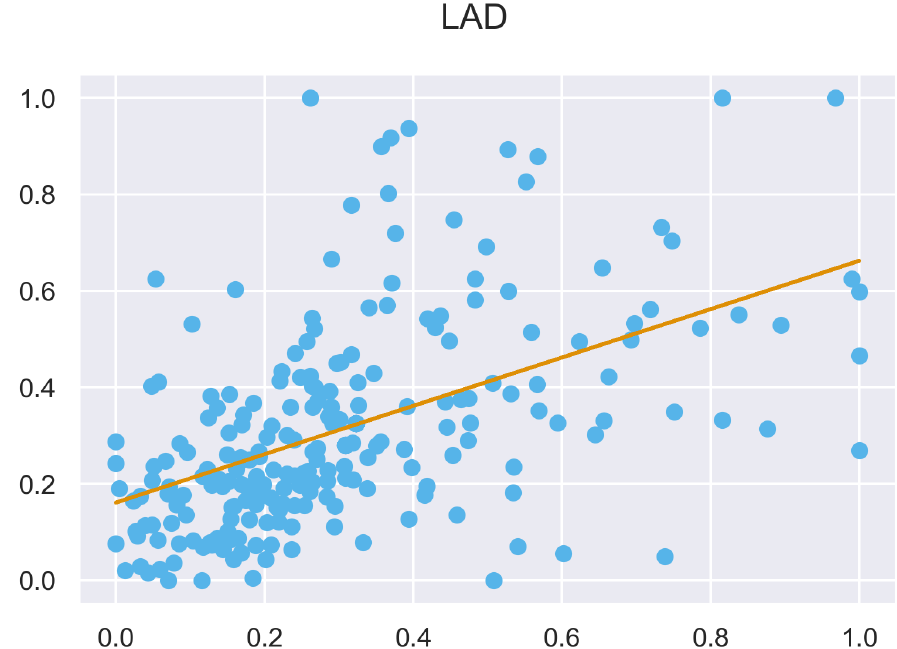
Figure A49. ULS and TLS LAD regression at 5m grid size.